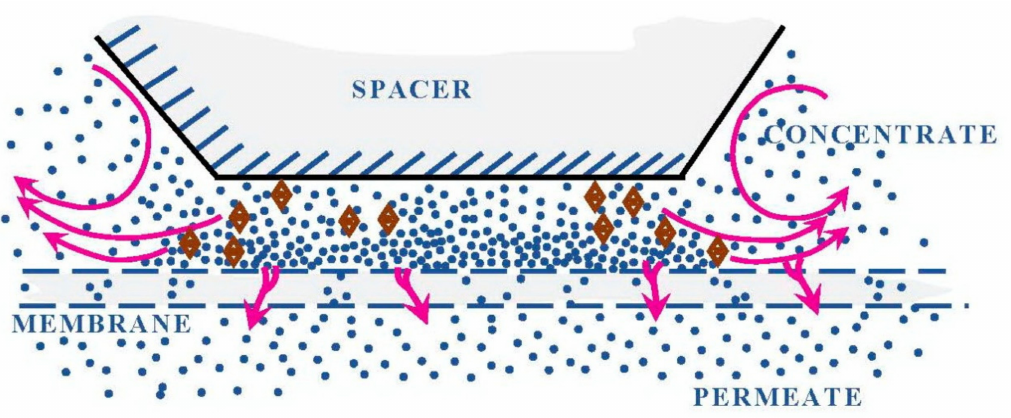
Figure 3. “Dead areas” formation on membrane surface due to spacer contact with membrane surface. Crystal formation and withdrawal from “dead areas” and further fouling of membrane